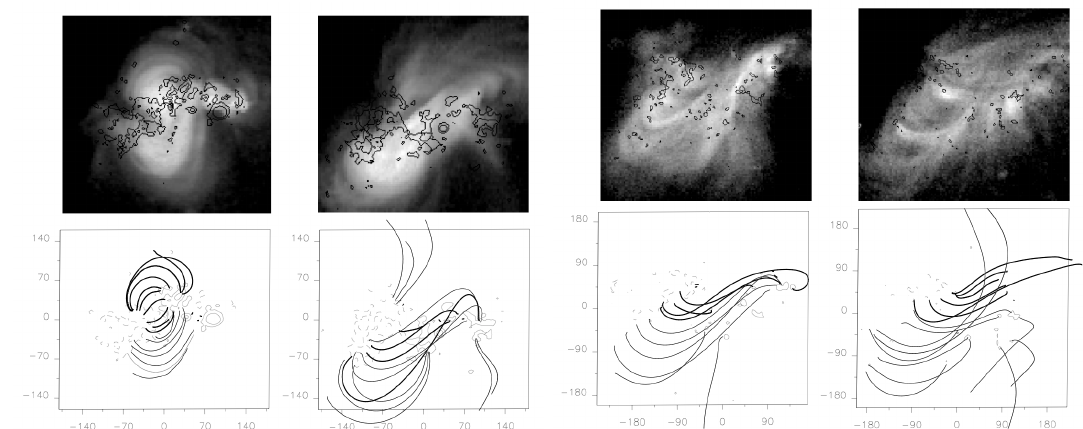
Figure 26: Yohkoh /SXT observations and linear force-free computations of the coronal field using SOHO/MDI magnetic maps. The 1st and 2nd columns correspond to Aug. 3 and 30, while 3rd and 4th columns to Sep. 25 and Oct. 23, respectively. The 𝛼 value is selected to have the best global match between the computed field lines and the observed SXT loops. We have drawn with thick (thin) continuous lines the field lines computed taking the highest (lowest) value of 𝛼 , and have represented them on the same figure. The abscissas and ordinates in each map are expressed in Mm. Isocontours ( ± 100, 500, 1000 G) of the line of sight magnetic field have been drawn with continuous/dashed lines for positive/negative values. Image reproduced with permission from Mandrini et al. (2004), copyright by